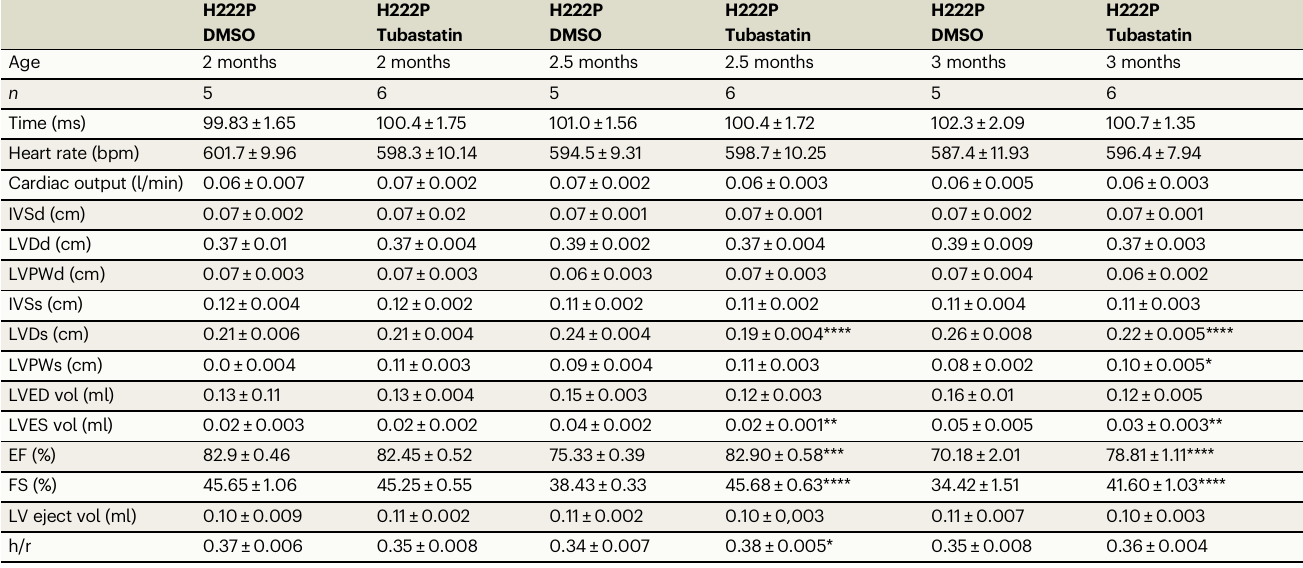
Table 3 | Echocardiographic data for Lmna p.H222P/H222P (H222P) mice treated with tubastatin A or DMSO at 2, 2.5,